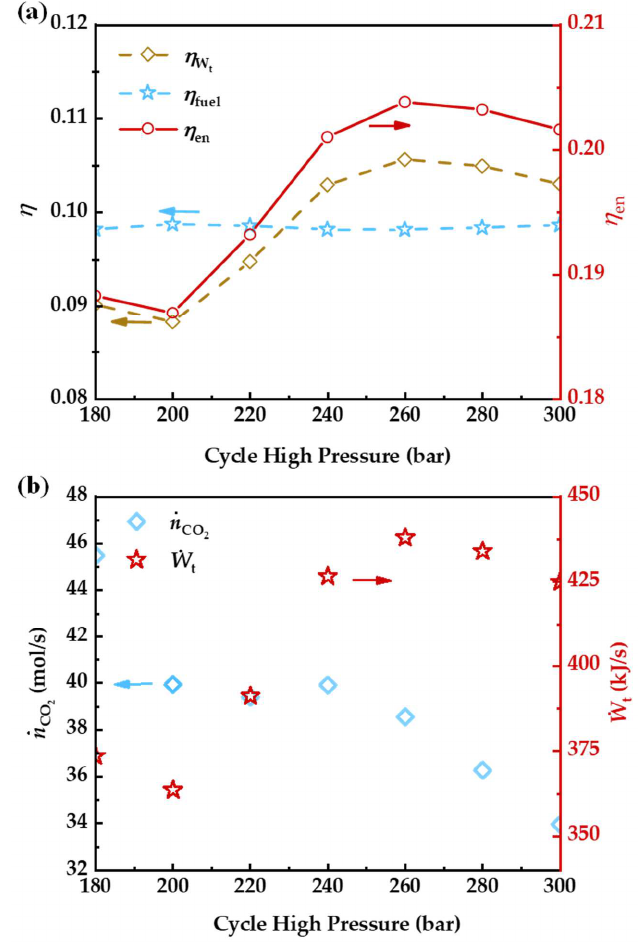
, h , and h ( P red = 10 −4 bar), ( b ) influence of , and η en ( P red = 10 − 4 bar), ( b ) influence of fuel en t W t . . ɺ ɺ n CO W t ( T red = 1900 K, T ox = 1300 K, P red = 10 − 4 bar, α = 0.95, ε gg = 0.9, and n W 2 and ( T red = 1900 K, T ox = 1300 K, P red = 10 −4 bar, α = 0.95, ε gg = 0.9, t 2 CO